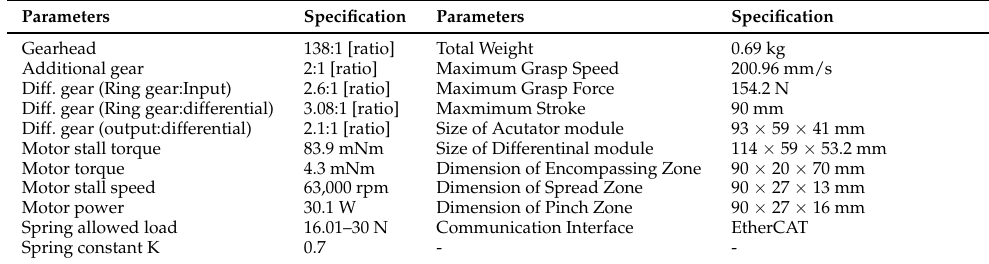
Table 1. Parameter specifications of two-way self-adaptive